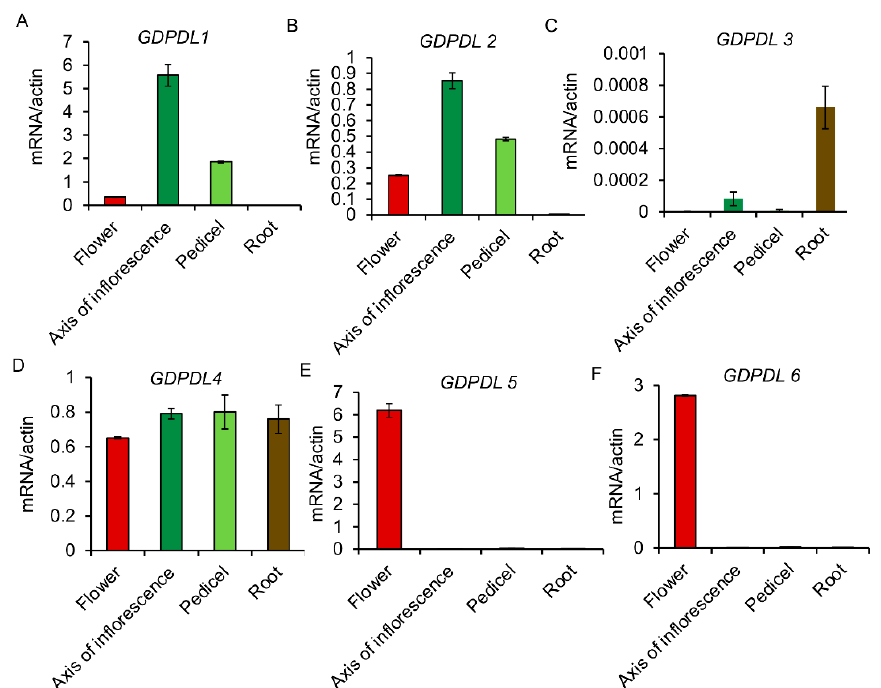
Figure 6. Organ-specific expression of the GDPDL genes. Total RNA was extracted from different Arabidopsis organs (as indicated in the figure) of 35-day-grown plants. We used 3 samples of different pools of 10 plants each (therefore n = 3, biological replicates), and the transcript levels of the indicated genes (GDPDL1, GDPDL2, GDPDL3, GDPDL, GDPDL5, and GDPDL6) were determined by qRT-PCR using gene-specific primers. The gene expression was calculated by the 2 − ∆ CT method using actin as an endogenous control. The error or standard bars indicate the mean ± SD (n = 3 biological replicates + n = 3 technical replicates each) of three independent experiments.